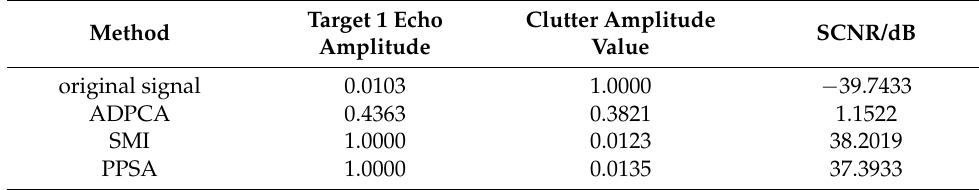
Table 14. SCNR comparison of target